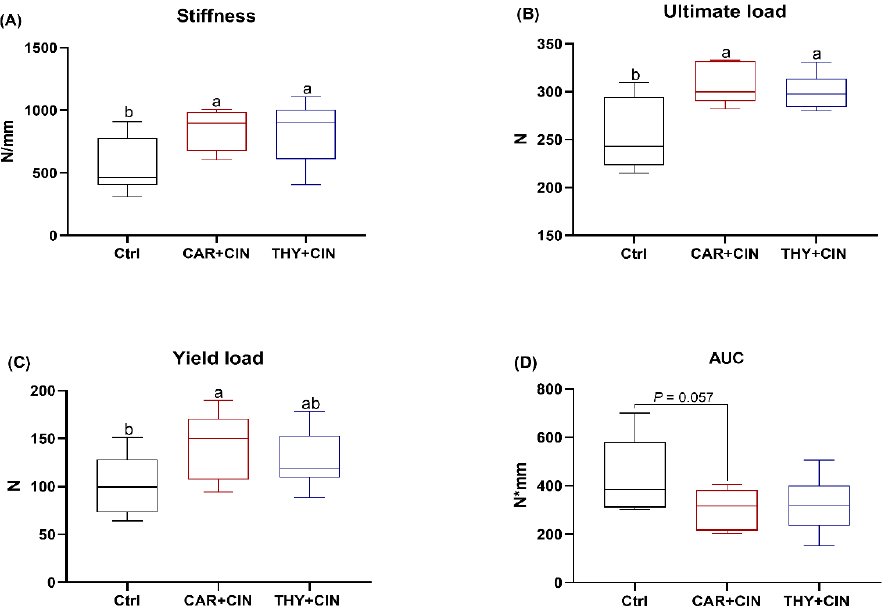
Figure 2. Impacts of the combination of cinnamaldehyde with carvacrol (CAR+CIN) or thymol (THY+CIN) on tibia mechanical properties of laying hens: ( A ) stiffness (N/mm); ( B ) yield point (N); ( C ) ultimate load (N); ( D ) area under the load–displacement curve (AUC, work to failure, N*mm). Boxes are bounded by the 25th and 75th percentiles, with the median shown by the line bisecting the box. Whiskers extend to the full range of the data. a,b Values without common superscript are notably different ( p < 0.05, n = 8).